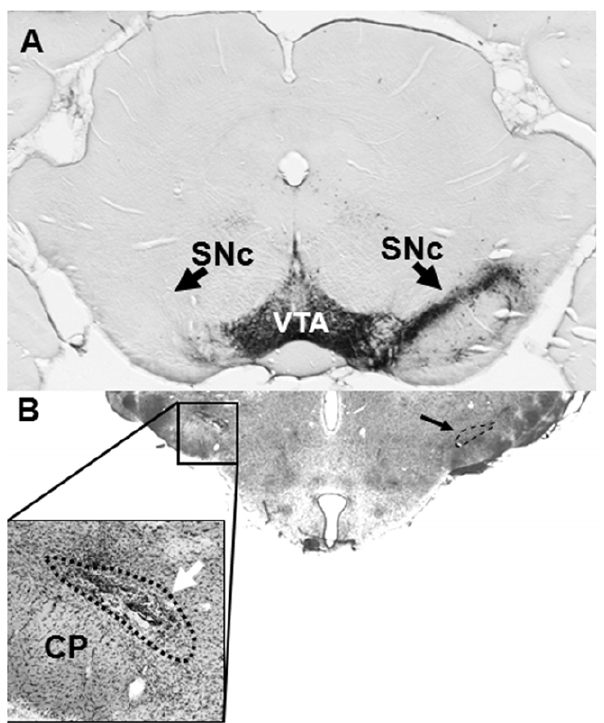
Figure 1. Nigral and subthalamic lesions. (A) Depletion of TH- immunoreactive neurons in left substantia nigra pars compacta, as compared with the unlesioned right side (arrows). (B) Electrolytic ablation of left subthalamic nucleus (white arrow; outlined by black dotted line); results were only analyzed from animals in which at least 50% of the subthalamic nucleus was lesioned; the intact contralateral subthalamic nucleus is indicated on the right side (small black arrow; dashed outline). CP=cerebral peduncle, SNc=substantia nigra, pars compacta, VTA=ventral tegmental area.